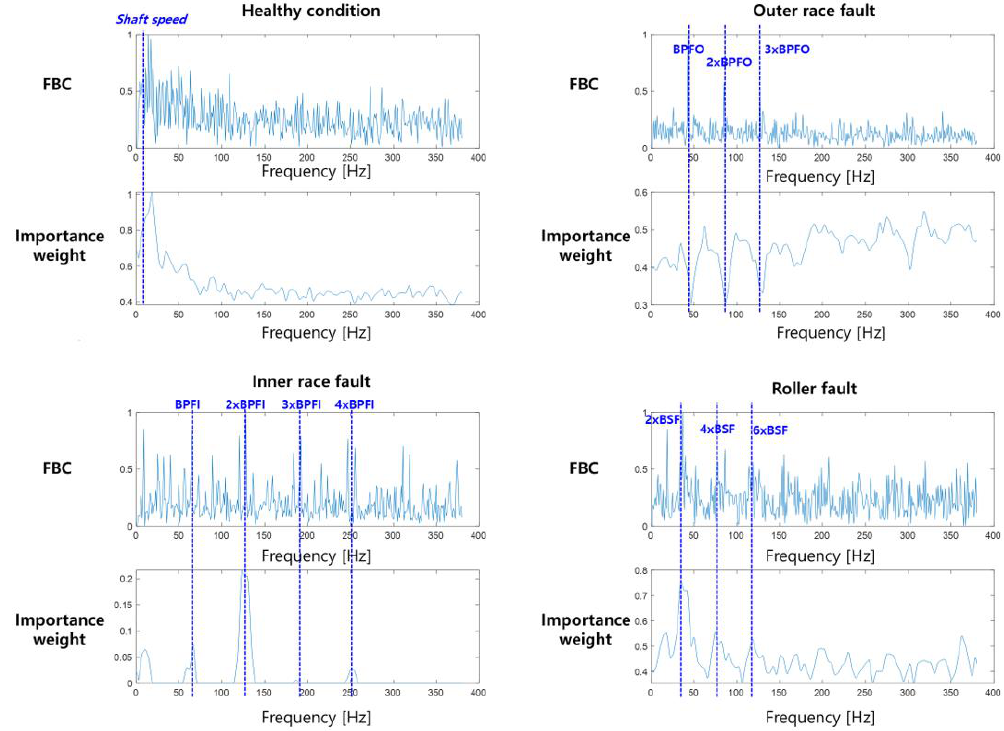
Figure 12. Importance-weights for each bearing failure.